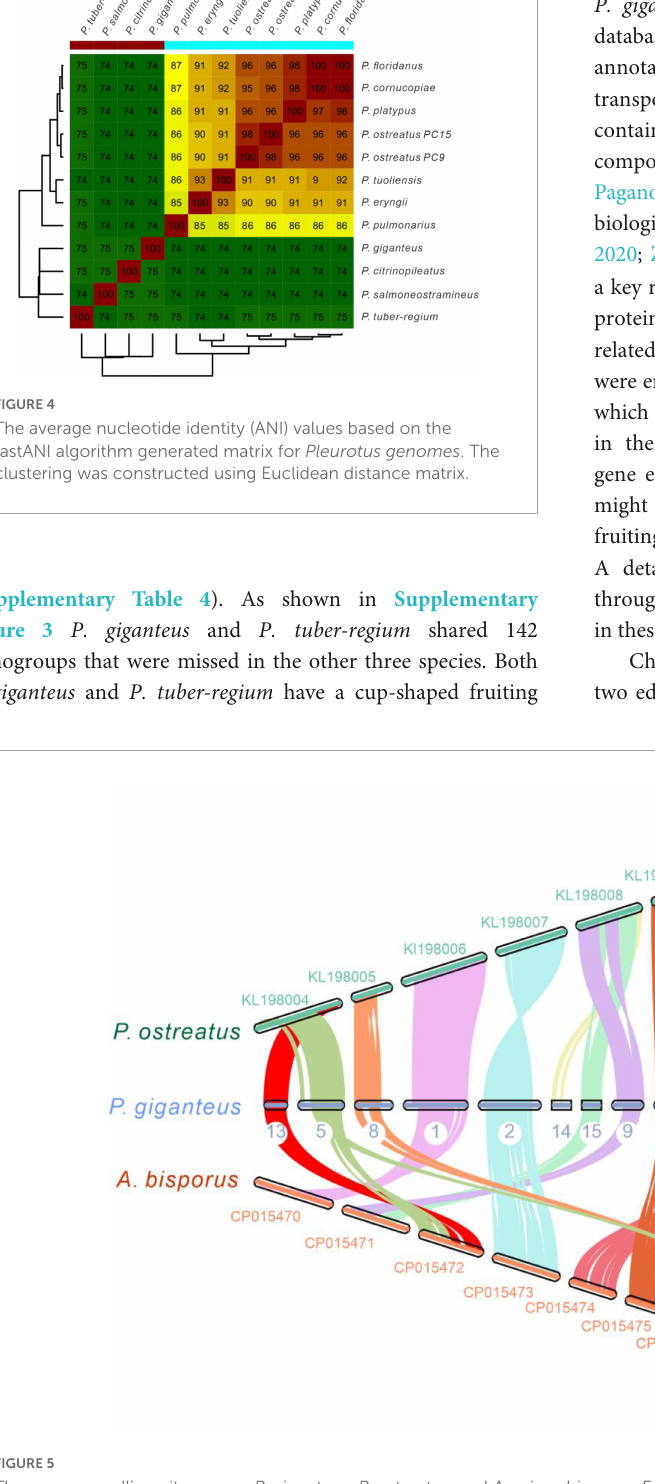
FIGURE5 The genome collinearity among P. giganteus , P. ostreatus, and Agaricus bisporus . Each line connects a pair of collinearity blocks between two genomes. Different colors represent different scaffolds of P. giganteus . Scaffold with no collinearity was not